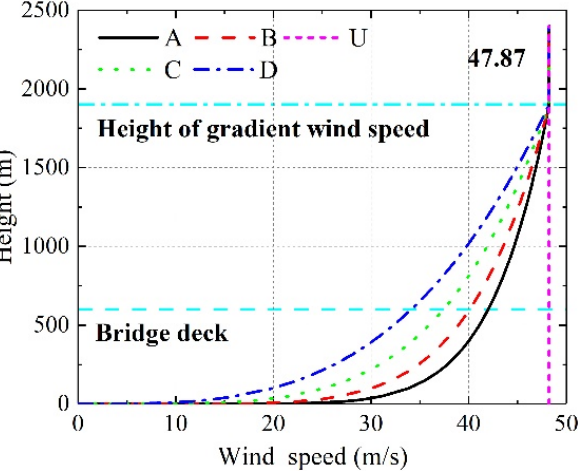
Figure 7. Wind speed profile of oncoming wind.